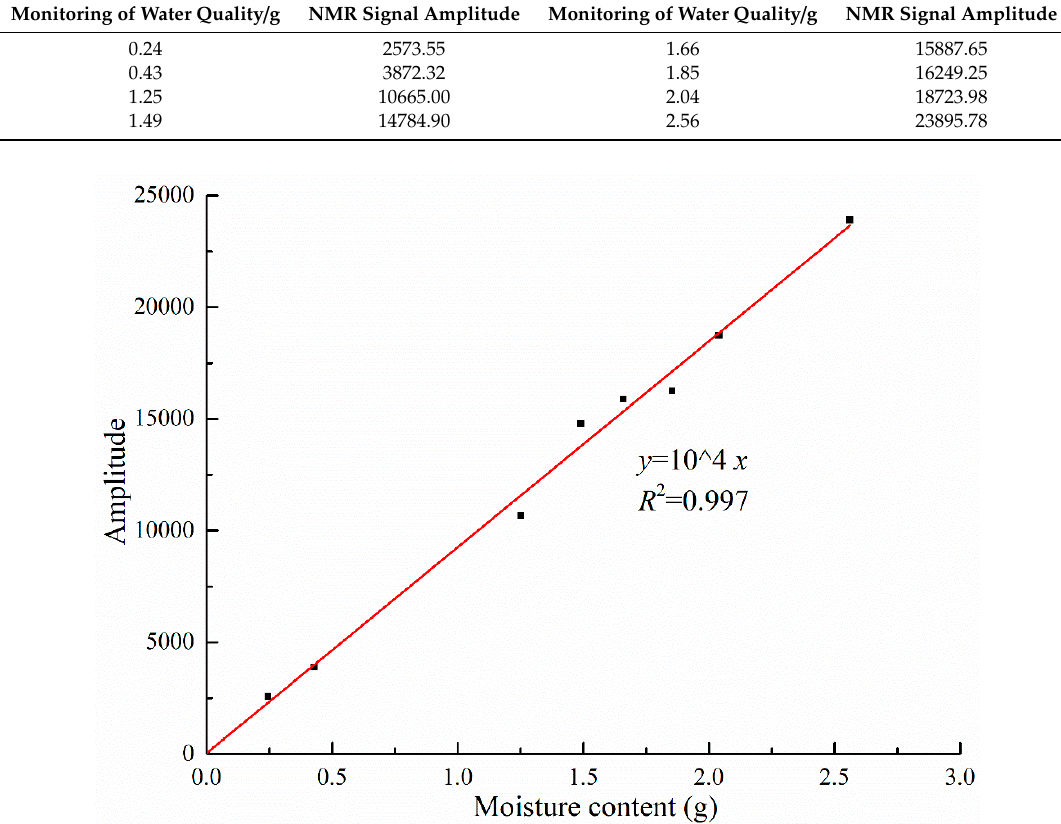
Figure 5. Test results of water sample calibration.